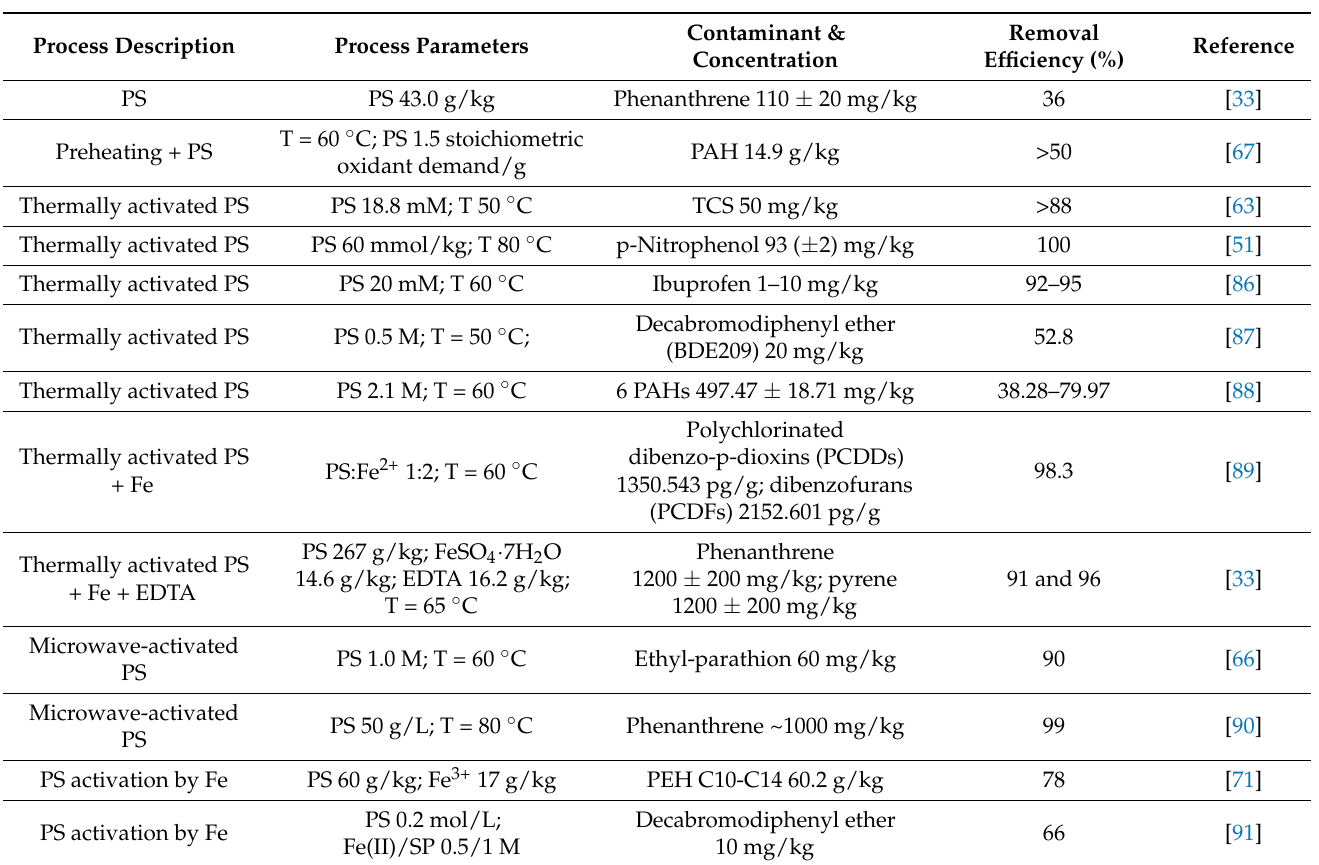
Table 2. Summary of soil decontamination results reported in the literature based on the PS activation